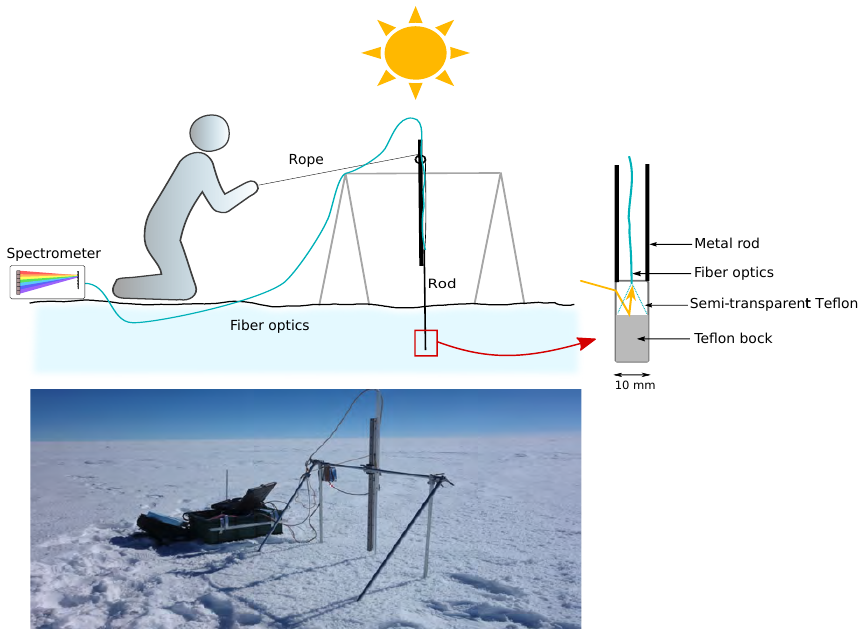
Figure 1. Scheme and picture of SOLEXS. The rod (black) is vertically guided and inserted in the snow with the rope manipulated by the operator. The quadripod (gray) is oriented to minimize the shadows. At the bottom end of the rod, the light first traverses the semi-transparent 0.5mm thin Teflon cylinder and is reflected by a Teflon block towards the fiber tip, from which it is transferred to the